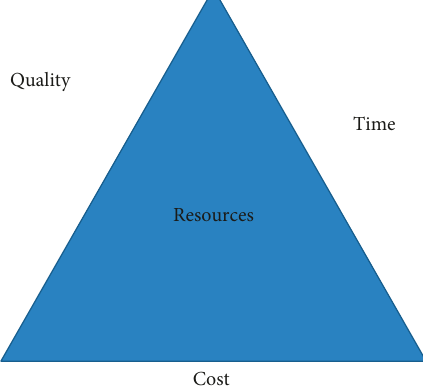
Figure 1: Project management